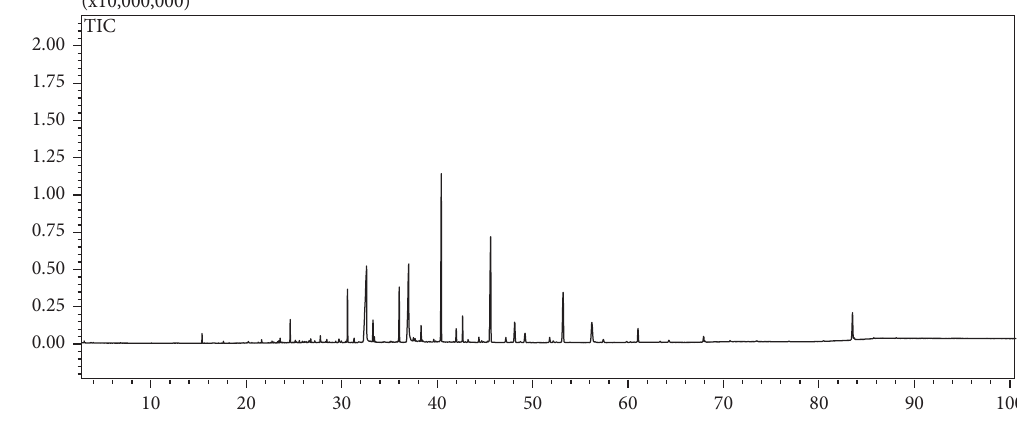
Figure 1: GC-MS of the essential oil from fresh S. rugosoannulata fruiting